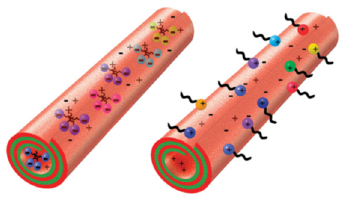
Figure 2. Scheme of selective anionic and cationic amphiphilic molecules adsorbed on the inside and outside of halloysite nanotubes. Reproduced with permission from Ref. [79]. Copyright 2016 John Wiley and Sons.